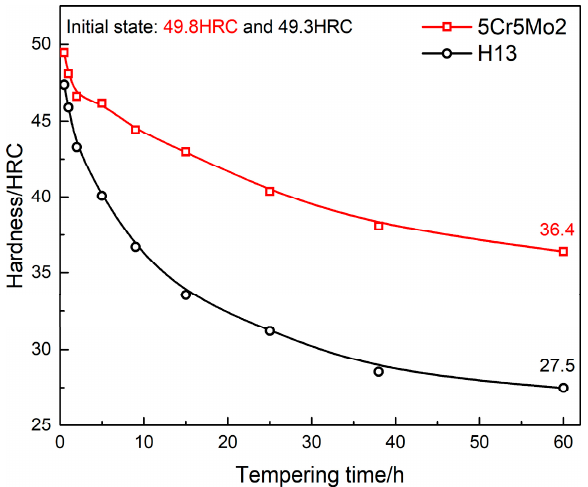
Figure 5. Hardness of the 5Cr5Mo2 and H13 steel alloys as functions of the tempering duration.